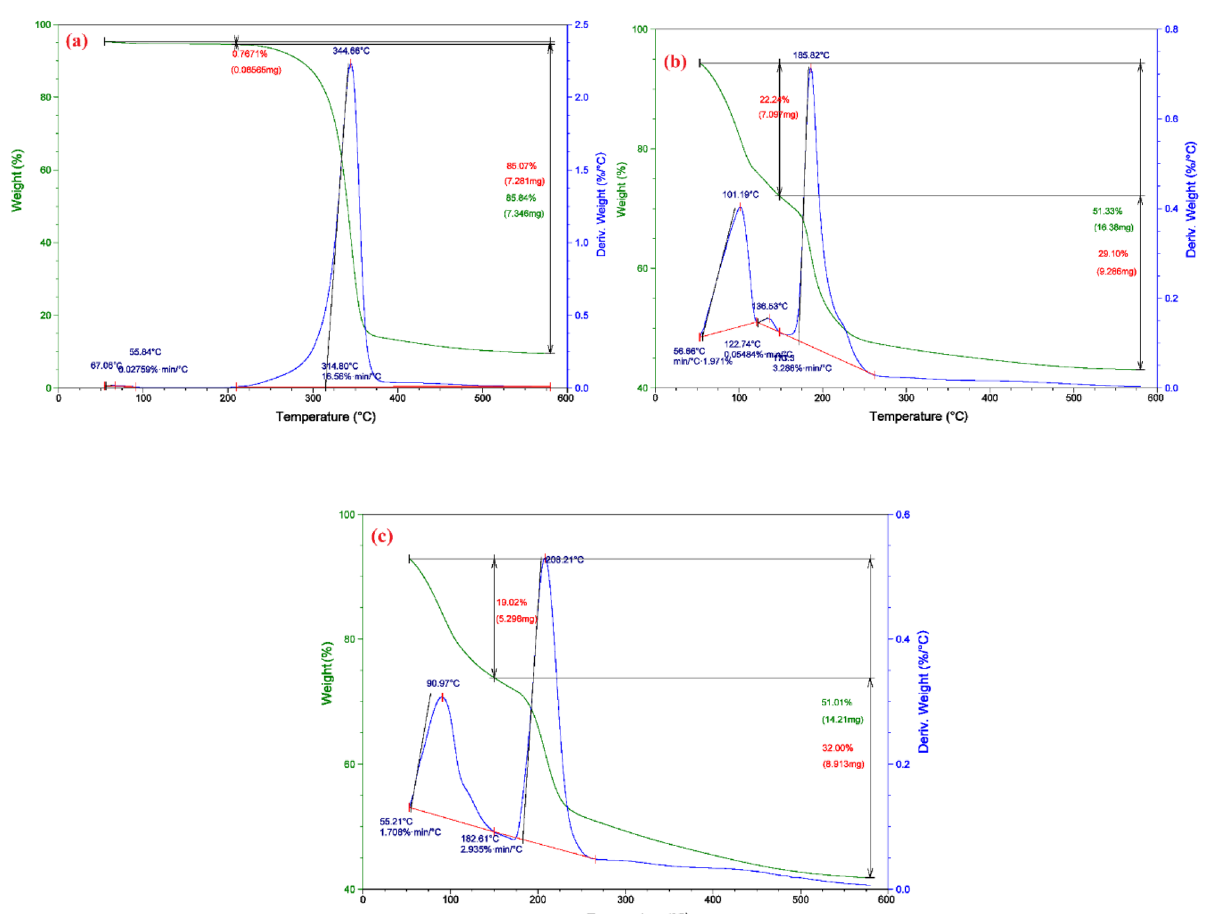
Figure 3. TGA, DTA of ( a ) Cellulose (C), ( b ) Cellulose Hydrogel (CAH), and ( c ) DB86 dye-Cellulose Hydrogel